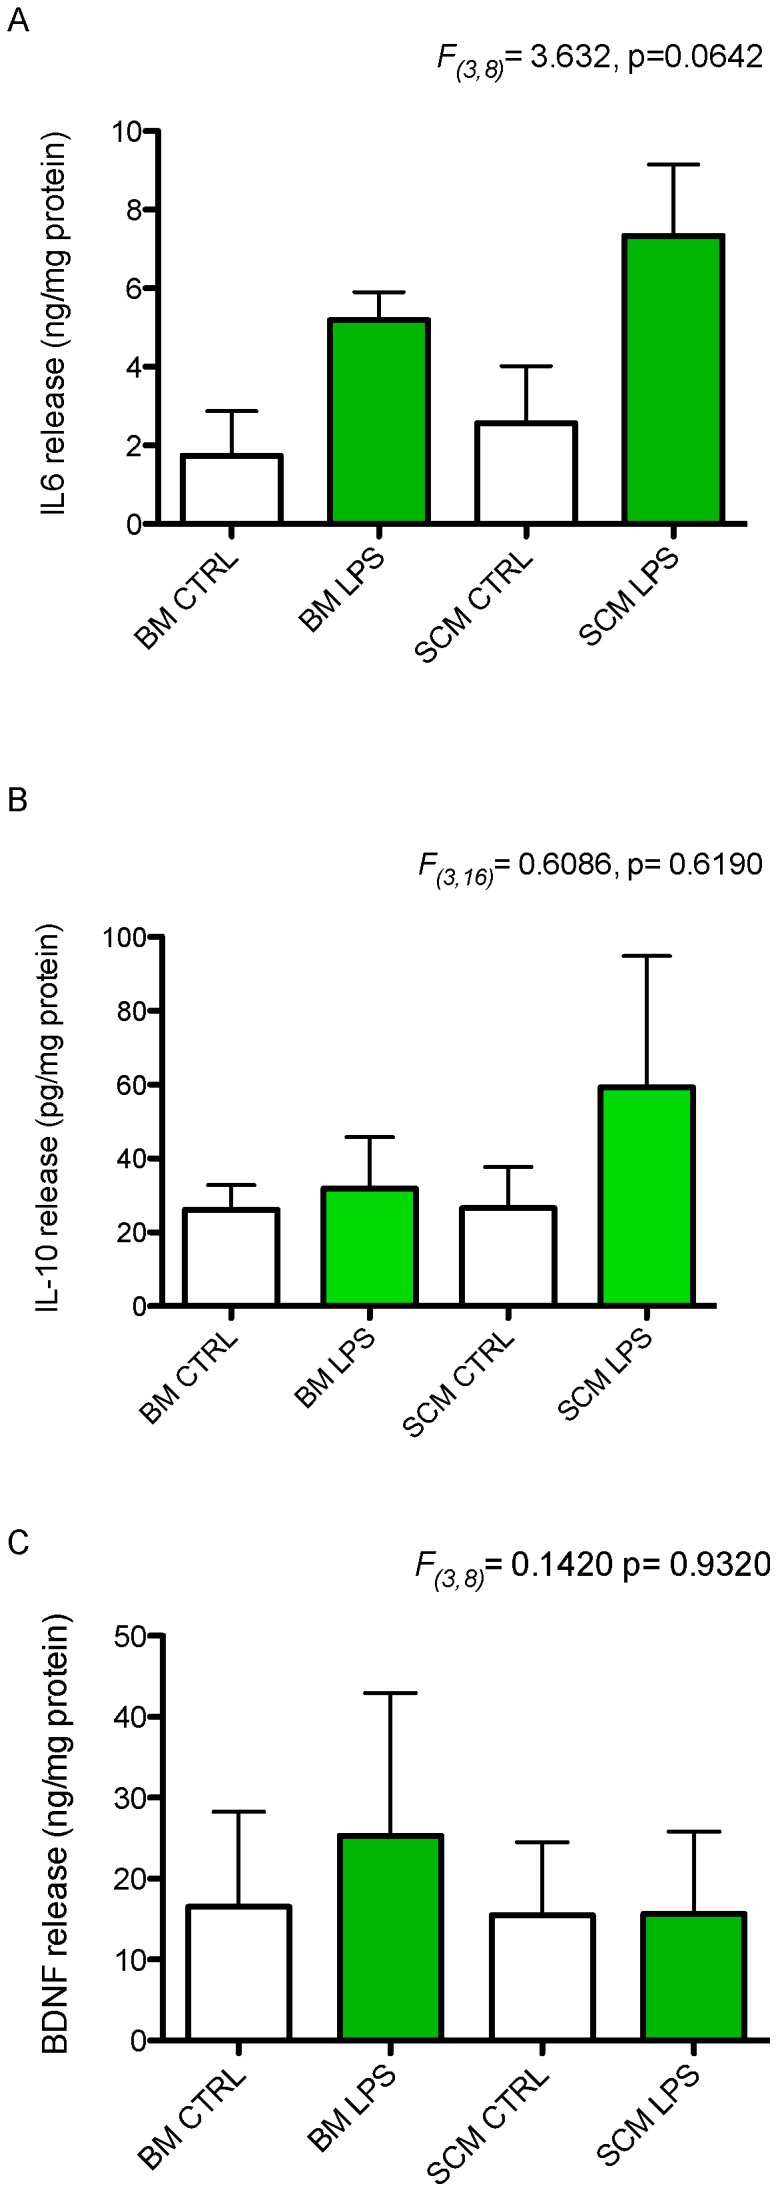
Release of IL-6, IL-10, and BDNF by SCM and BM under basal conditions and after LPS activation.BM and SCM were activated with LPS to measure the difference in their release of these cytokines and trophic factors. (A) There was no significant main effect of treatment group on IL-6 release (ANOVA, F(3,8) = 3.632, p = 0.0642, n = 3) on IL-6 release. LPS activated BM and SCM exhibited a trend towards increased in release of IL-6 compared to their respective controls. Similarly, a significant main effect of treatment was not observed for either IL-10 release (B, ANOVA, F(3,16) = 0.6086, p = 0.6190, n = 5) or BDNF release (C, ANOVA, F(3,8) = 0.1420, p = 0.9320, n = 3). n represents the number of independent experiment with a minimum of three replicates. Bars represent cytokine or trophic factor per milligram of total protein ± s.e.m.